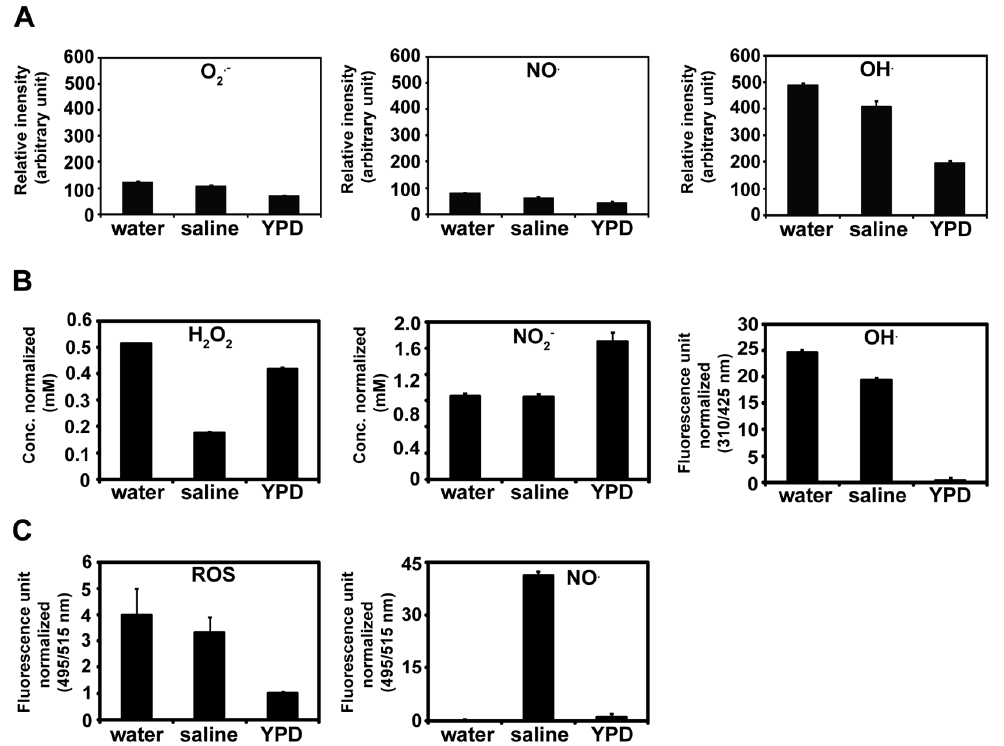
Figure 6. The level of reactive oxygen species (ROS) and reactive nitrogen species (RNS). ROS and RNS levels were measured on the surface of solutions ( A ), and inside solutions ( B ) and cells ( C ) after Ar gas and plasma treatments. Absorbance values in (A) were measured by optimal emission spectroscopy and are the average of five replicates. In (B) and (C), all values are normalized, in which the level measured after Ar gas treatment was subtracted from that measured after plasma treatment. Each value is the average of three technical replicates.